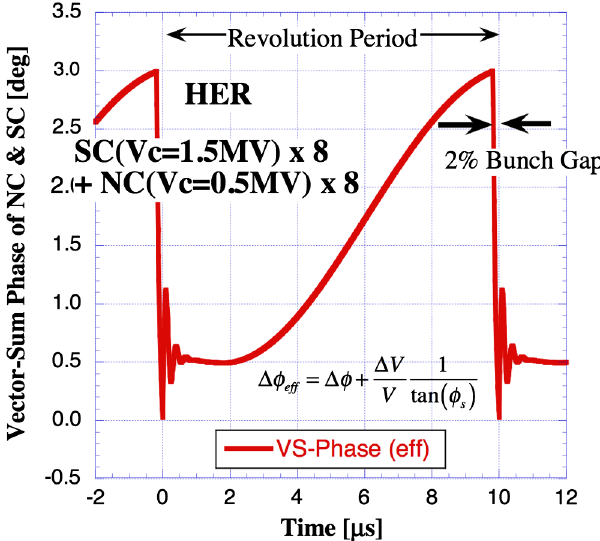
FIG. 11. Phase modulation of the vector sum of ARES and SCC voltage simulated for HER.